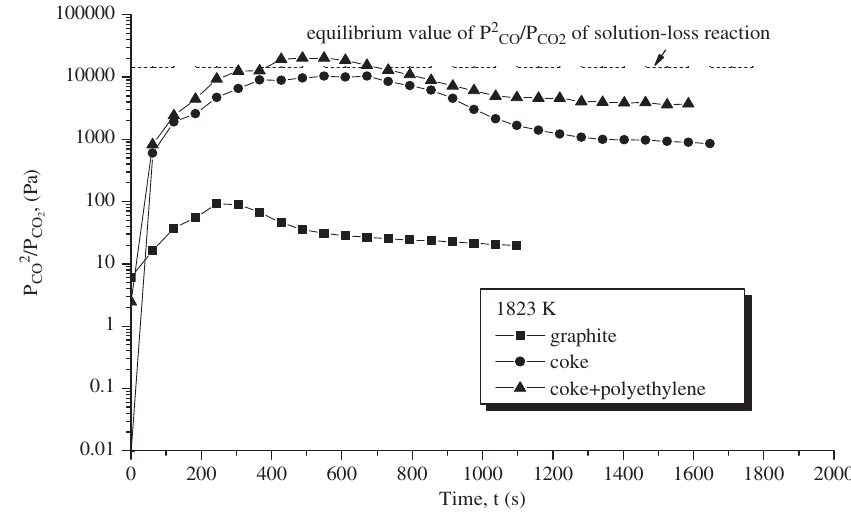
(cid:1) of carbonaceous substrates with the equilibrium value of solution-loss p co co 2